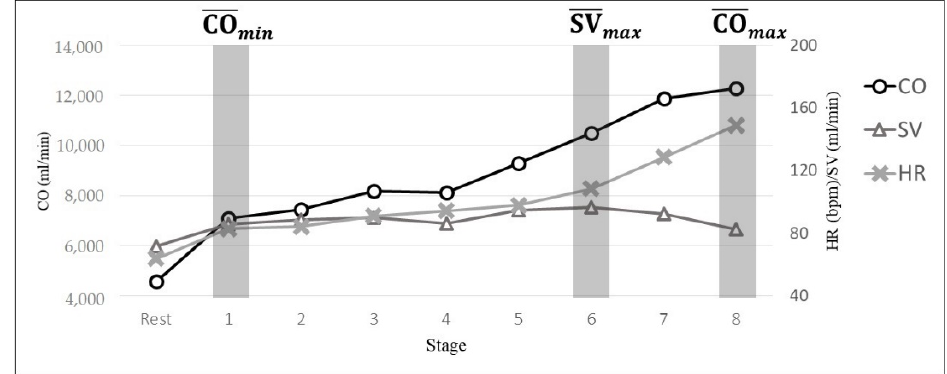
Figure 5. The line chart of patient parameters during incremental physical load. Example from patient #25.